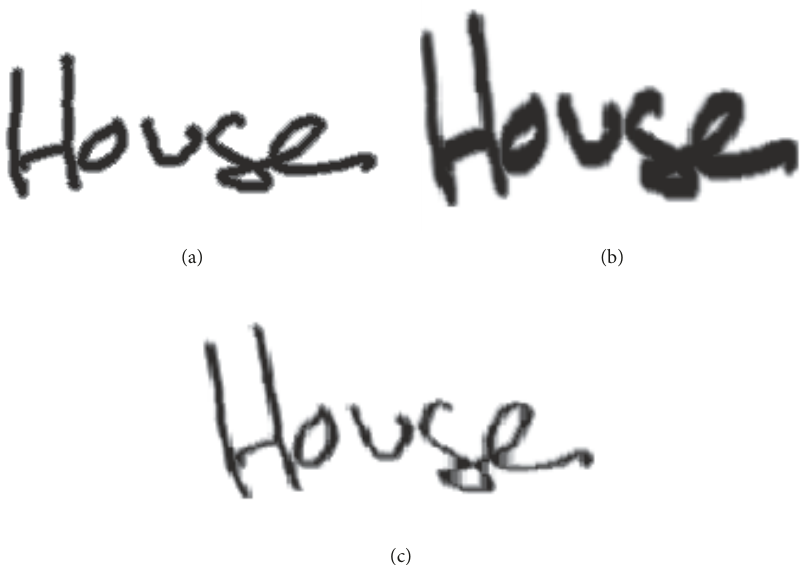
Figure 4: Some examples of combined transformations applied to a sample training word: (a) original image; (b) synthetic image obtained from (a) by successively applying a − 5 ∘ inclination, a vertical scaling of 20%, and a morphological dilation; (c) synthetic image obtained from (a) by successively applying a − 10 ∘ inclination, both vertical and horizontal scaling of 10% and a morphological